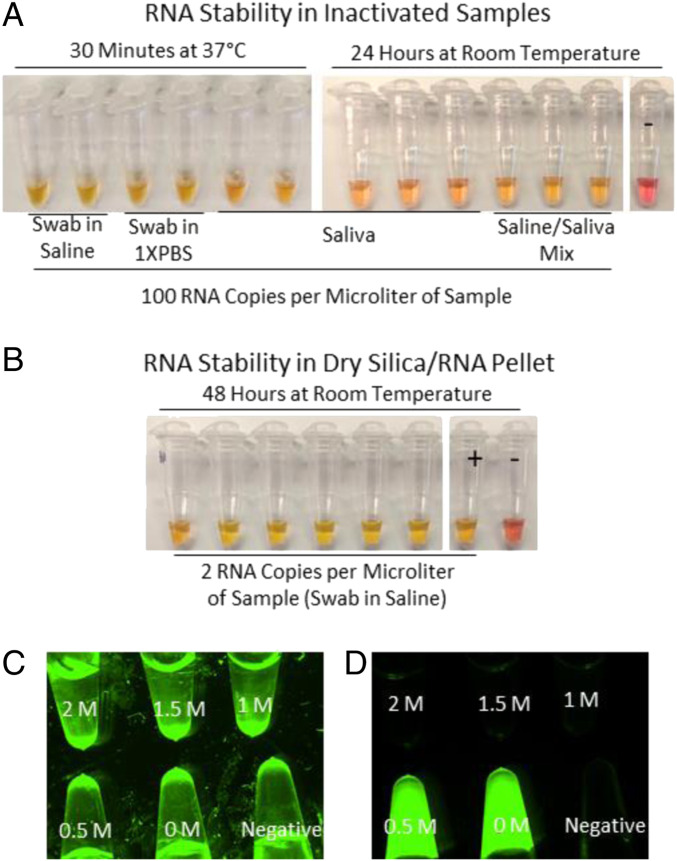
Evidence for RNA stability from inactivation through purification. (A) Swabs in saline, swabs in 1× PBS, saliva, or a 1:1 mixture of saliva and saline was inactivated and spiked with control RNA to 100 copies per microliter. After inactivation, samples were incubated for 30 min at 37 °C for 30 min or 24 h at room temperature, as indicated, before 5 μL was added to colorimetric RT-LAMP reaction mix with Orf1a-HMSe primers. (B) The 500-μL swabs in saline were purified using glass milk with a centrifuge. Dried RNA/silica pellets were left at room temperature for 48 h before adding colorimetric RT-LAMP reaction mix with Orf1a-HMSe primers. Negative control sample (−) had no RNA copies added to sample. Positive control reactions (+) had 1,000 RNA copies spiked directly into the reaction. (C and D) RNase activity from swabs placed directly into NaI solutions (concentration indicated). RNase Alert reactions incubated for 30 min at 37 °C; (C) bright field, (D) 488 nm fluorescence channel; fluorescence indicates RNase activity.